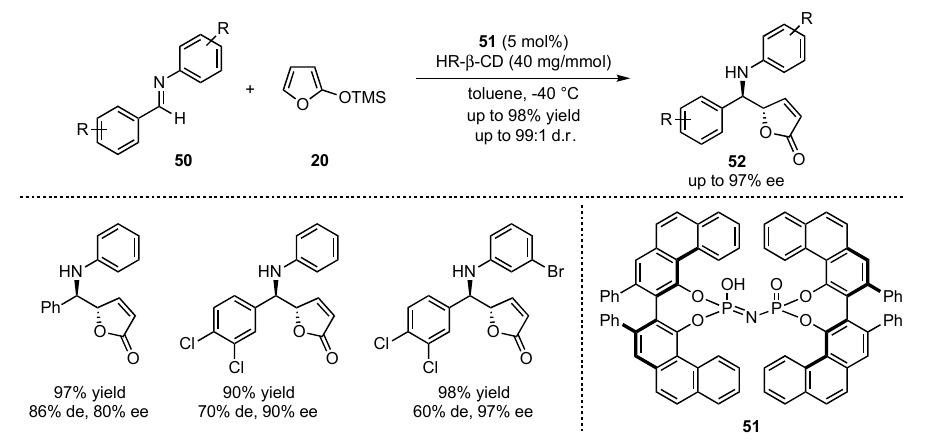
Scheme 14. Improved method for the organocatalyzed asymmetric VMMnR between aromatic aldimines and silyl-dinolates renouncing the necessity of neighboring hydroxy-groups presented by Zhang et al. [46].